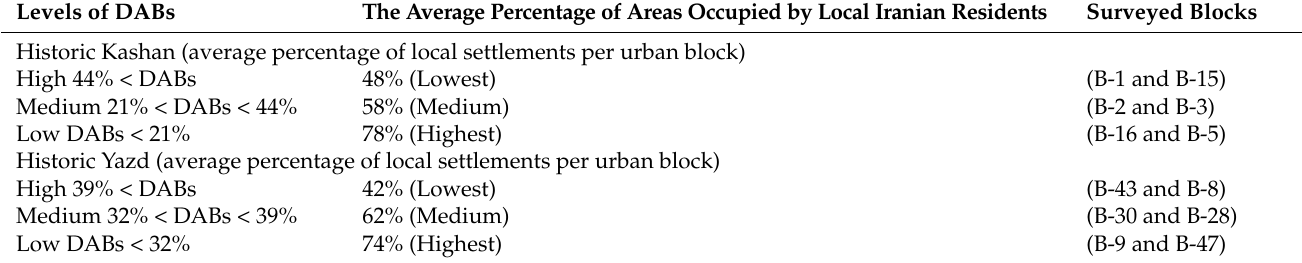
Table 2. Analysing aspects of spatial liminality of DABs in 12 case